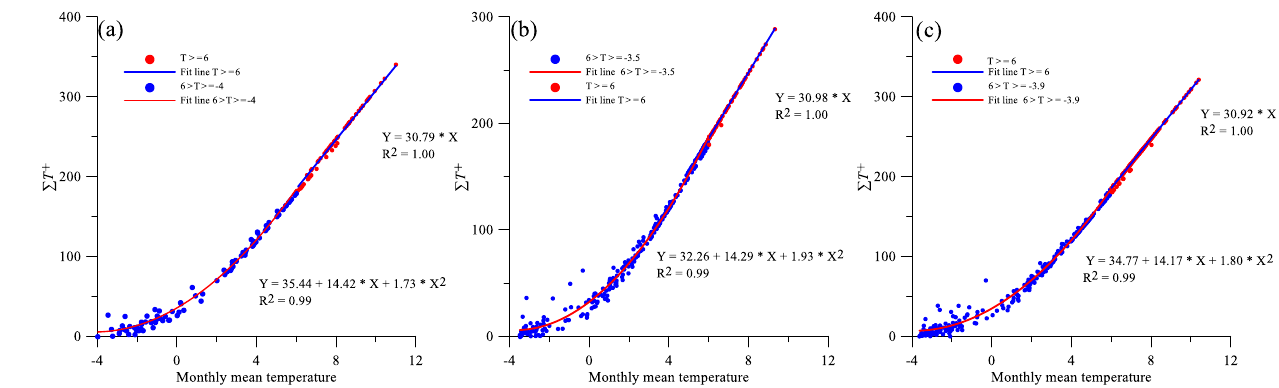
Figure 4. Relationship between monthly mean temperature and monthly positive accumulated temperature (1961–2013). Panels (a, b, c) indicate Qumalai, Qingshuihe and Maduo station, respectively.